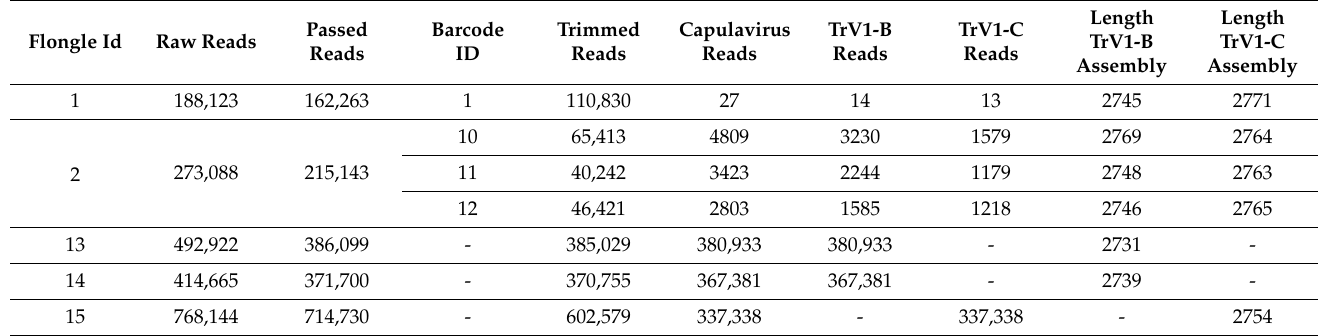
Table 1. Long read sequencing